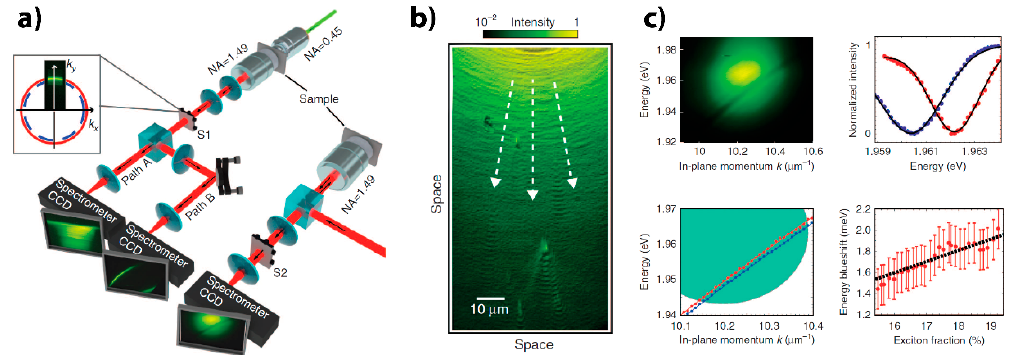
Figure 4. ( a ) In the upper part, a sketch of the leakage radiation microscope setup in a non-resonant configuration. The excitation source (a cw laser at 2.33 eV) is focused on the sample from the organic deposition side. The emission is collected through a microscope objective with NA = 1.49. In the bottom part, a sketch of the resonant configuration. The excitation laser (100-fs laser pulse) is energetically matched with the BSWP mode and focused through the oil immersion objective. ( b ) Space map of the non-resonant excited polariton emission; the white arrows are a guide for the eye indicating the radial directions starting from the excitation spot (i.e., BSWP propagation direction). ( c ) BSWP nonlinearities. ( top left ) Bare experimental data of the BSWP dispersion in reflectance configuration at 150 μ J cm − 2 pumping energy. ( top right ) Energy-resolved signal at in-plane wavevector k = 10.34 μ m − 1 under 150 μ J cm − 2 and 10 mJ cm − 2 excitation energy densities (blue and red dots, respectively), showing the blueshift of the BSWP resonance. ( bottom left ) Experimental BSWP dispersions with 150 µ J cm − 2 (blue) and 10 mJ cm − 2 (red) resonant pump pulse. The green ellipse depicts the resonant laser central position and size in the energy–momentum domain (FWHM circle). ( bottom right ) The expected blueshift as a function of the excitonic fraction (black dashed line) fits the experimental results (red dots) for a bare exciton blueshift of 8 meV. (Adapted with permission from [42], Nature Publishing Group, 2017)